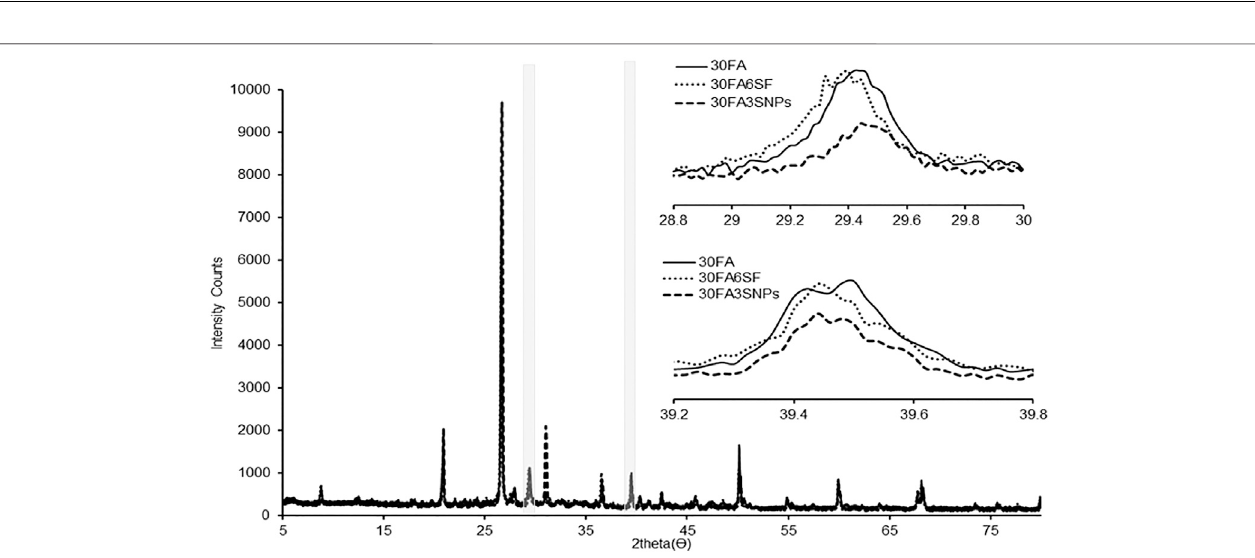
FIGURE 8 | X-ray curve of 30% fl y ash containing 3% SNPs and 6% SF mixes after 365 days of exposure.